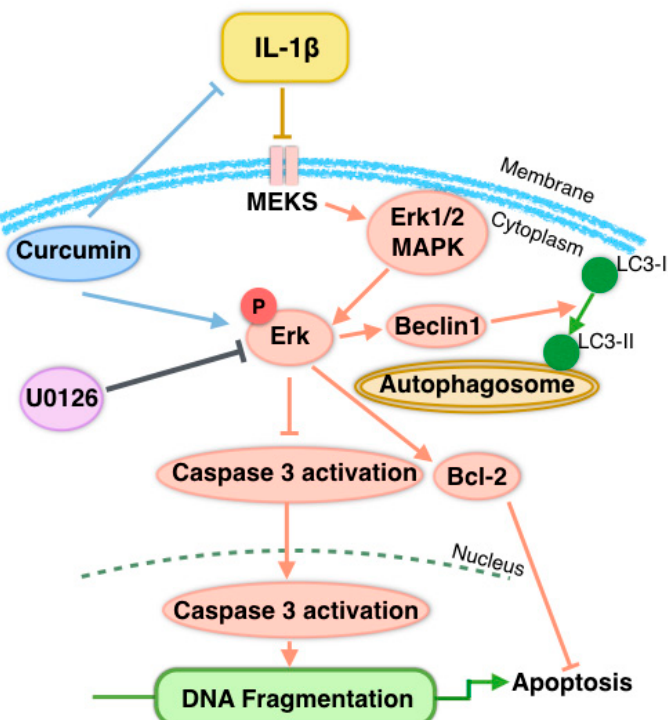
Figure 7. Curcumin induced autophagy via the ERK1/2 signal pathway to protect chondrocytes from apoptosis. IL-1 β stimulates the IL-1 β receptor, initiating an intracellular signal transduction cascade, which inhibits the cytoplasmic MAPK/ERK1/2 signaling pathway, then activates proinflammatory and pro-apoptotic gene production. ERK1/ERK2, a downstream kinase of the MAPK pathway, regulates the expression and activity of various transcription factors. Specific inhibition of ERK1/ERK2 by U0126 or IL-1 β results in cleavage of caspase-3 in primary chondrocytes in vitro. Since activation of caspase-3 and DNA fragmentation are common features of apoptosis, the specific inhibition of the Ras-mitogen-activated kinase leads to chondrocyte apoptosis. Curcumin blocks the inhibition effect of U0126 or IL-1 β on the MAPK pathway and activates autophagy in chondrocytes. Beclin-1 promotes LC3 activation. Recruitment and integration of LC3B-II into the growing phagophore, eventually results in the formation of